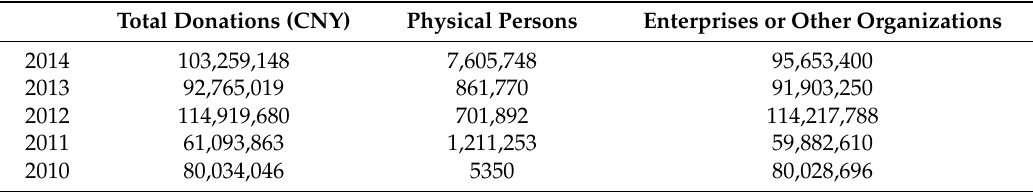
Table 2. Donations to China Green Carbon Foundation [28–32].